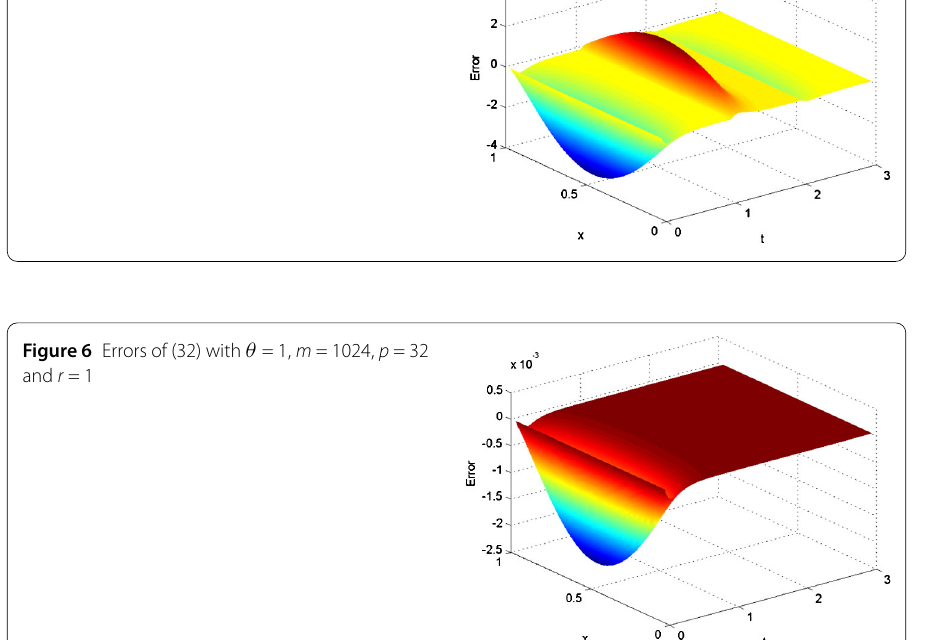
Figure 5 Errors of (31) with θ = 1, m = 1024, p = 32 and r = 1